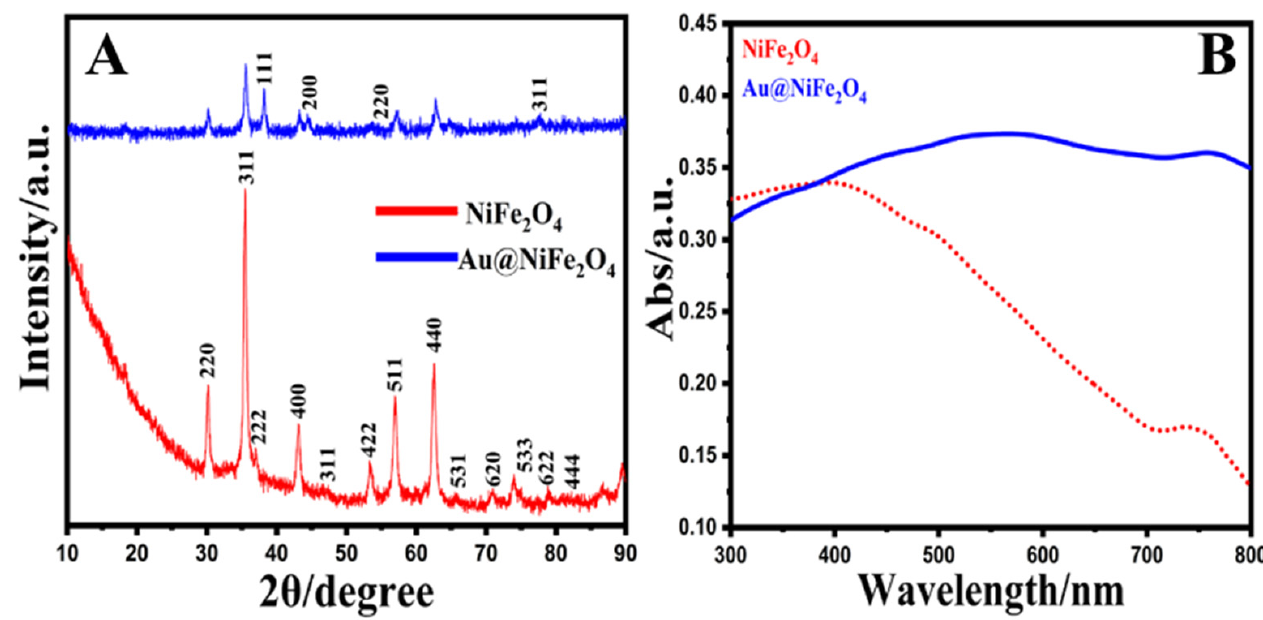
Figure 1. ( A ); XRD patterns of NiFe 2 O 4 and Au@NiFe 2 O 4 ( A , B ); UV–Vis spectra of NiFe 2 O 4 and Au@NiFe 2 O 4 .